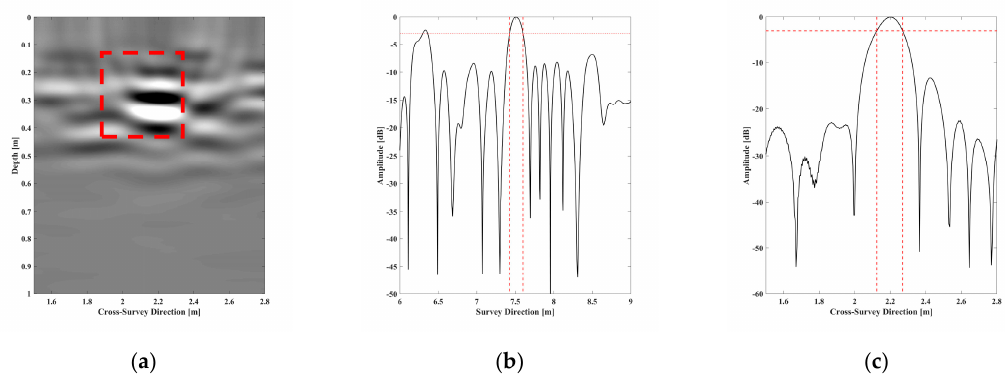
Figure 10. The coarse root detection in a 3D migrated cubic: ( a ) B-scan profile which contains a tree root. ( b ) Root extension tracking with the − 3 dB positions of a local peak (survey direction). ( c ) Root extension tracking with the − 3 dB positions of a local peak (cross-survey direction).